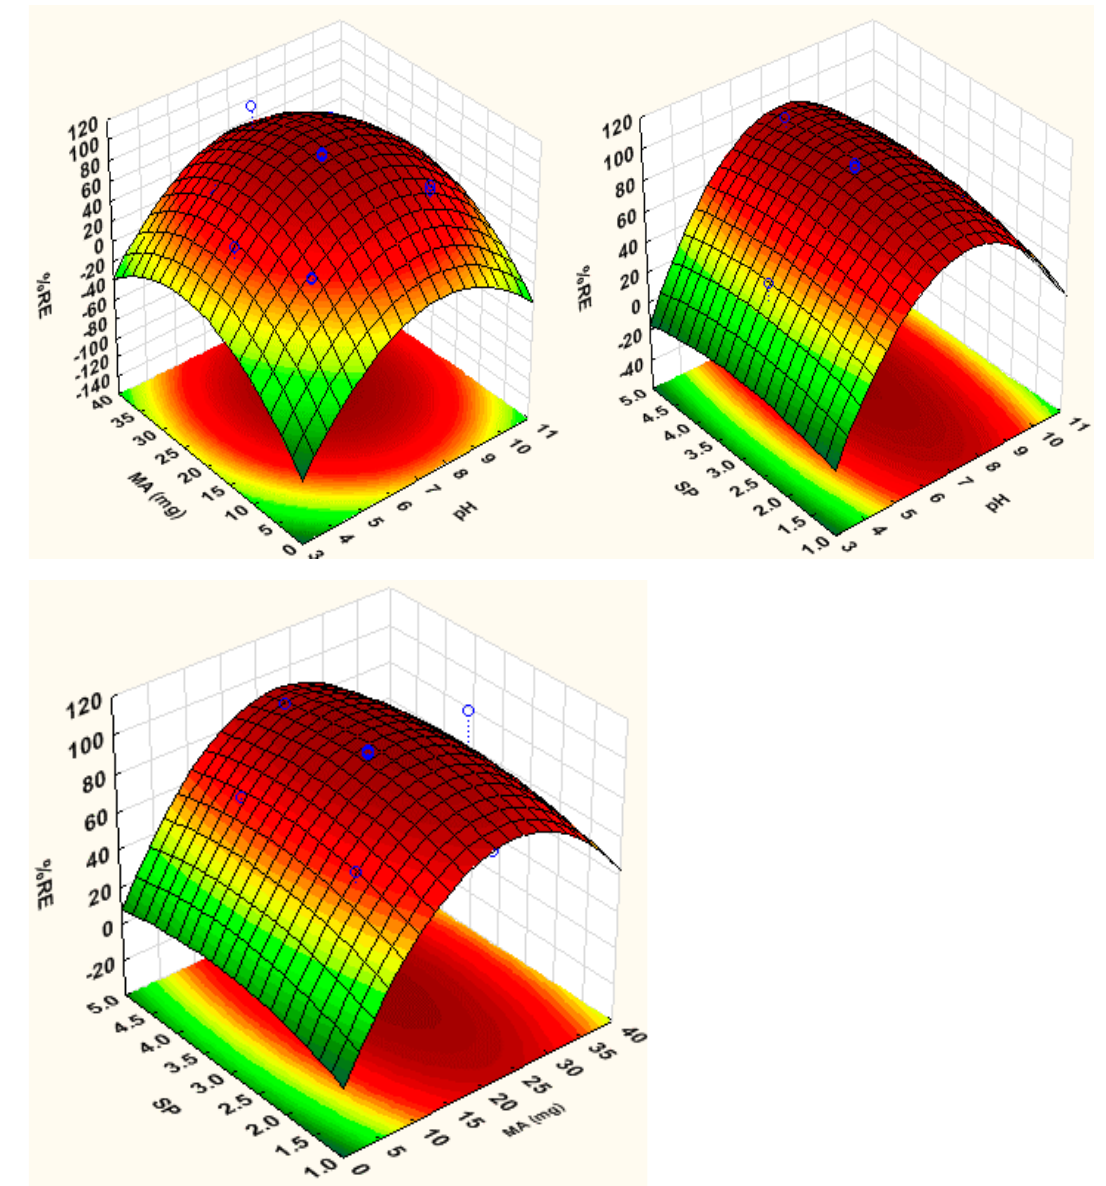
Figure A2. The 3D surface response plots describing the interactions of investigated parameters (LEVO).